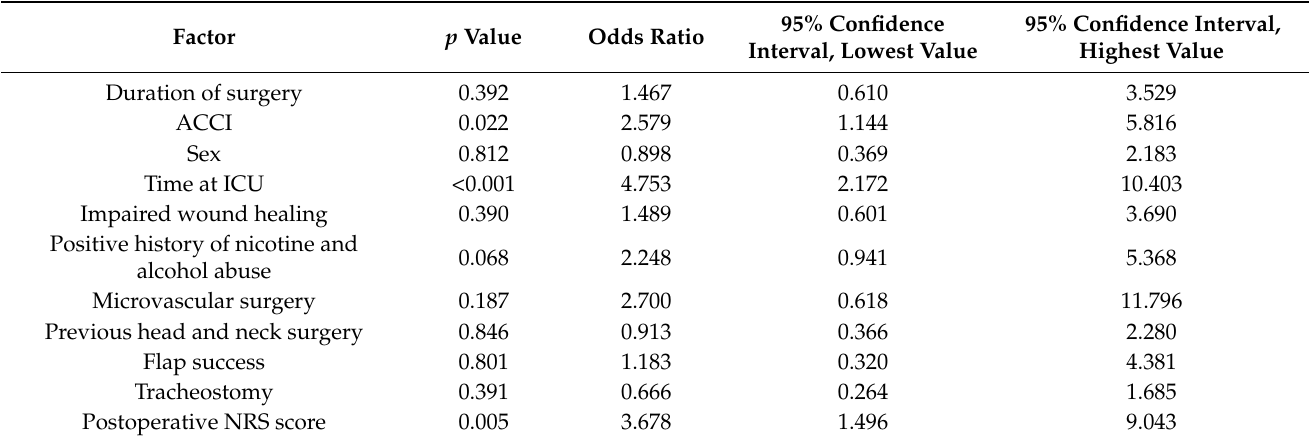
Table 2. Binary logistic regression of different clinicopathological parameters related to clinical diagnosis of delirium a